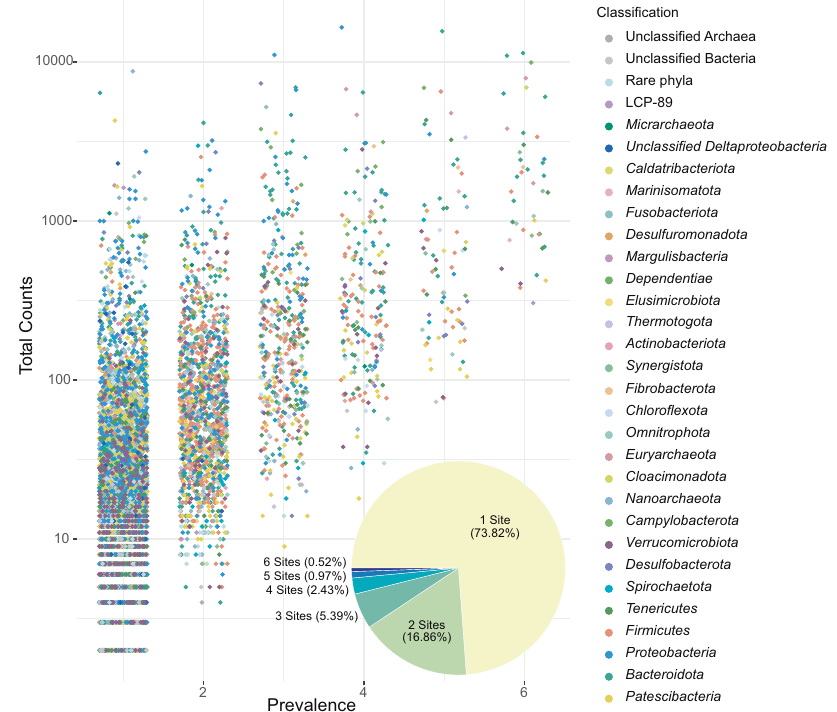
Fig. 4 Prevalence of 16 S rRNA amplicon ASVs across sampling sites. ASVs with individual counts greater than two from the top 25 most abundant phyla or present in four or more sites were included. The pie chart insert shows the proportion of ASVs present in one to six sites. Data from CLC_T1 0.1 and 0.2 µm fi lters were combined, because these samples represent the same biomass from the same site and sampling